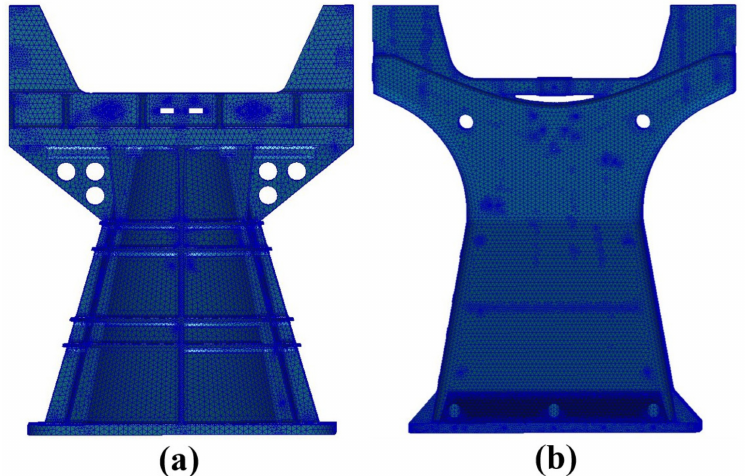
Figure 6. Finite element modeling of the vertical bracket. ( a ) The original model. ( b ) The bionic optimization model.